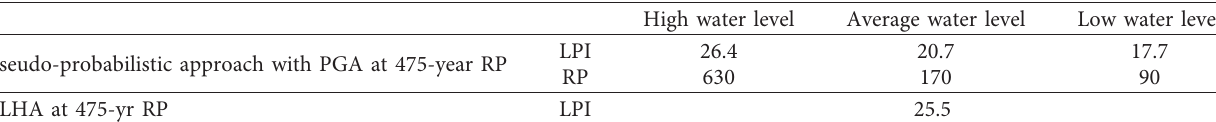
Table 3: Results of BH-S1 at different water table levels.